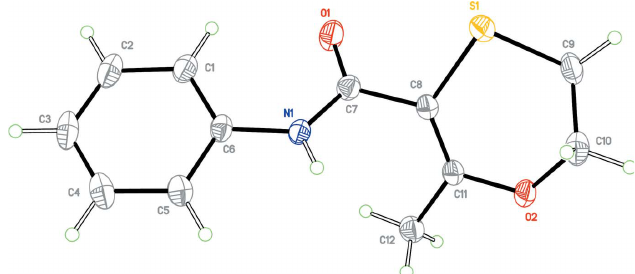
Figure 2 View of molecule B of the asymmetric unit of form 1 with the atom labelling scheme. Displacement ellipsoids are drawn at the 50% probability level.